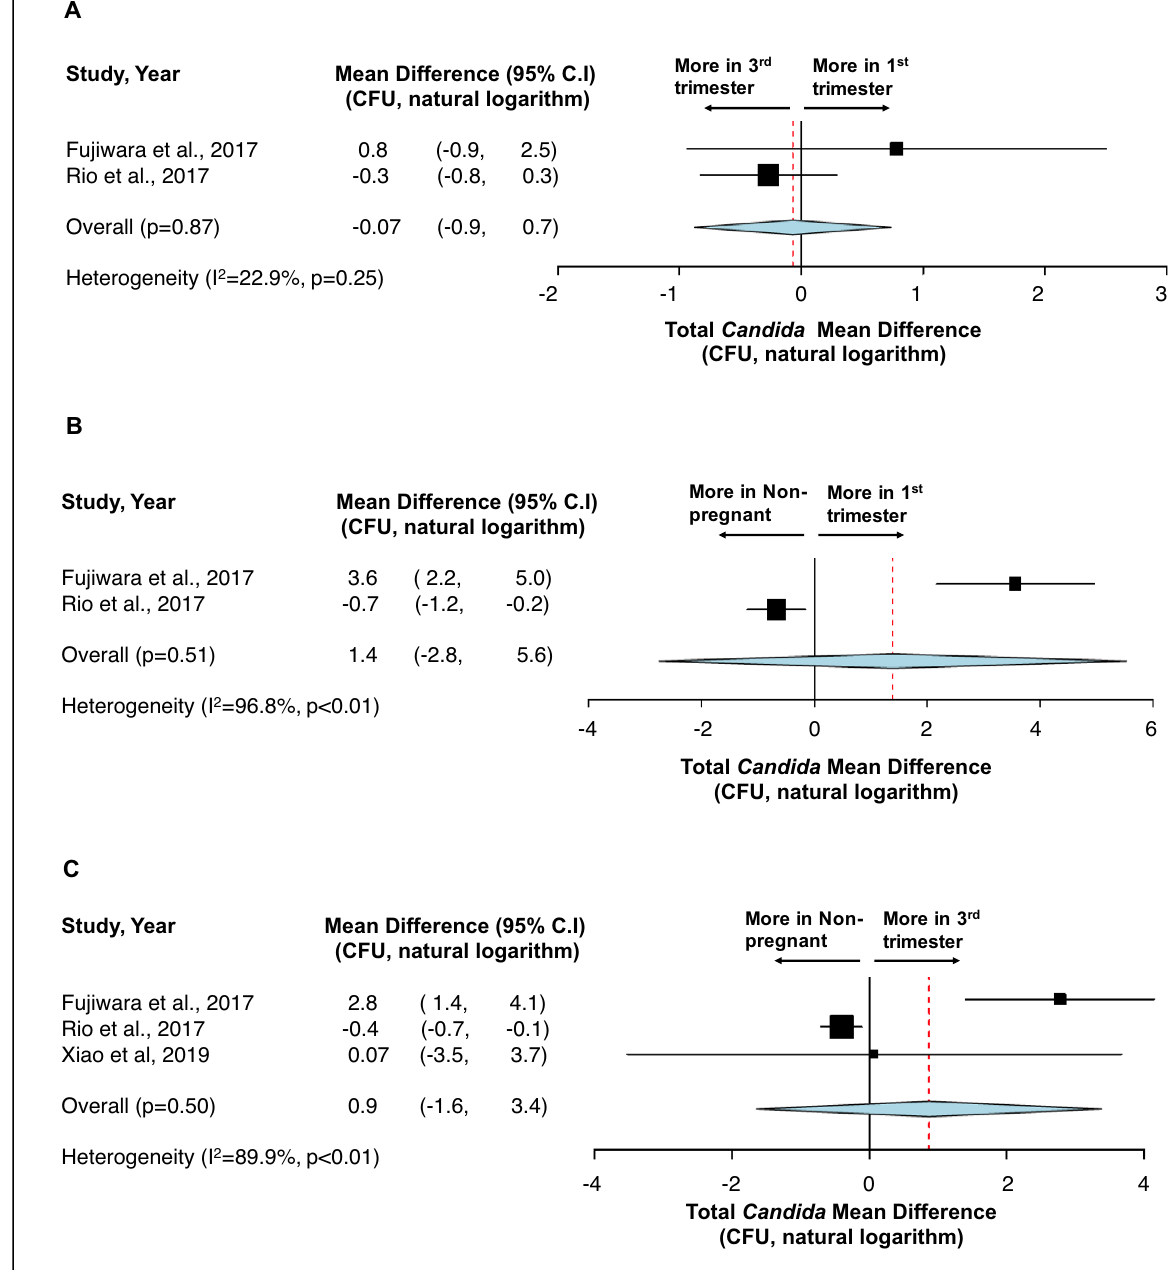
Figure 6. Impact of pregnancy status on salivary Candida carriage. The Mean differences of Candida carriage between 1st and 3rd trimester ( A ), between non-pregnancy and 1st trimester ( B ), and between non-pregnancy and 3rd trimester ( C ) indicated that oral Candida remain stable during the pregnancy and no differences (p > 0.05) are detected between pregnant and non-pregnant women. Study heterogeneity (I 2 ) and the related p value were calculated using the continuous random effect